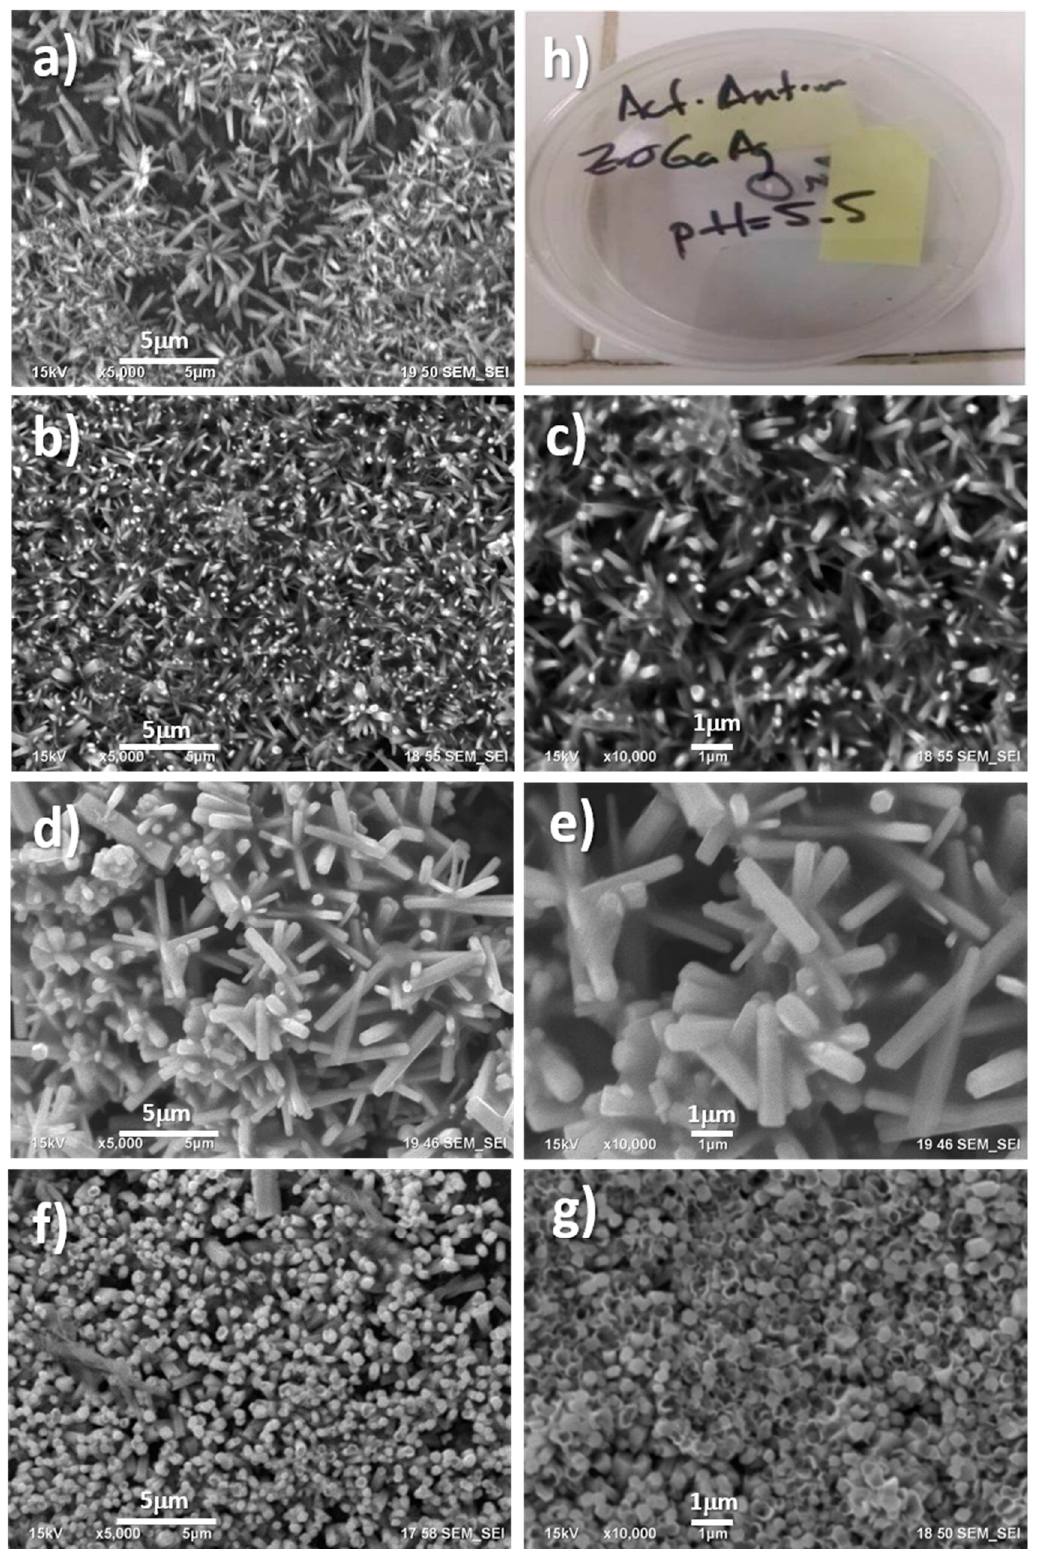
Figure 1. SEM images of the synthesized doped ZnO NRs: ( a ) AgGa-doped ZnO NRs, AgGaCl-doped ZnO NRs at pH 6 ( b , c ), pH 5.5 and ( d , e ) at pH 5.0 ( f , g ). ( h ) Samples of AgGaCl-doped ZnO NRs on PE substrate.